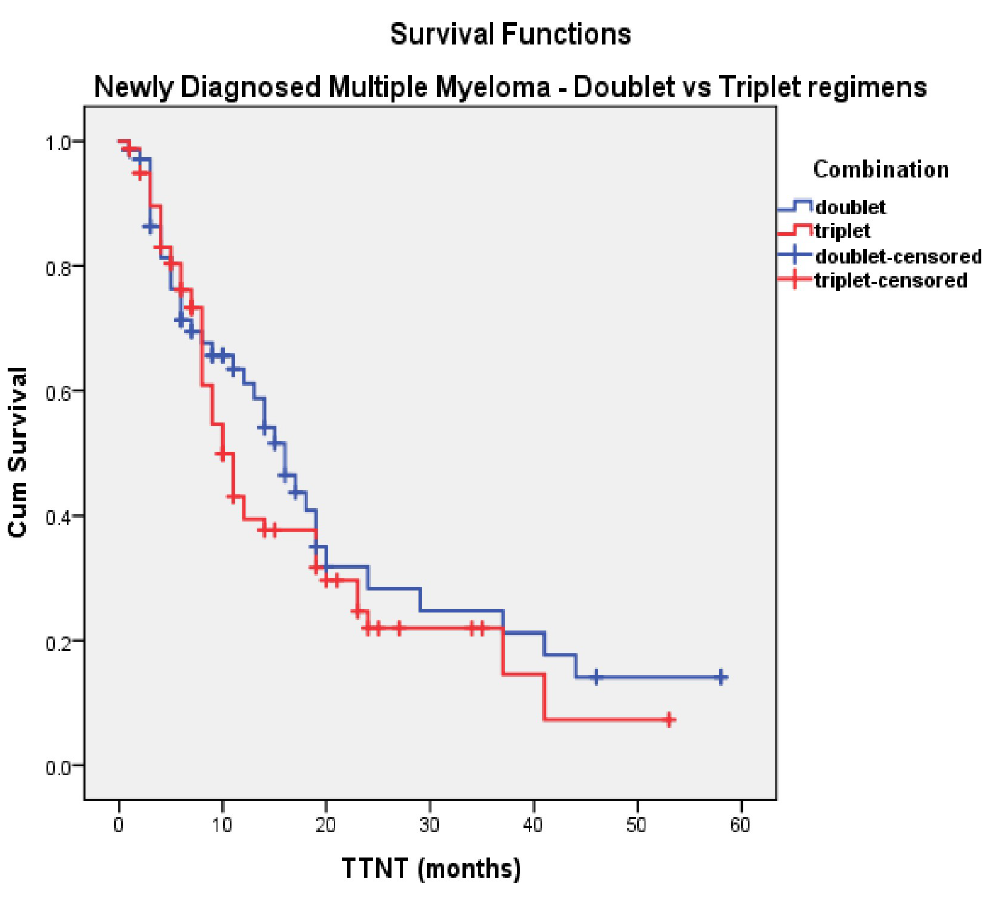
Fig 3. TTNT in NDMM (doublet vs.